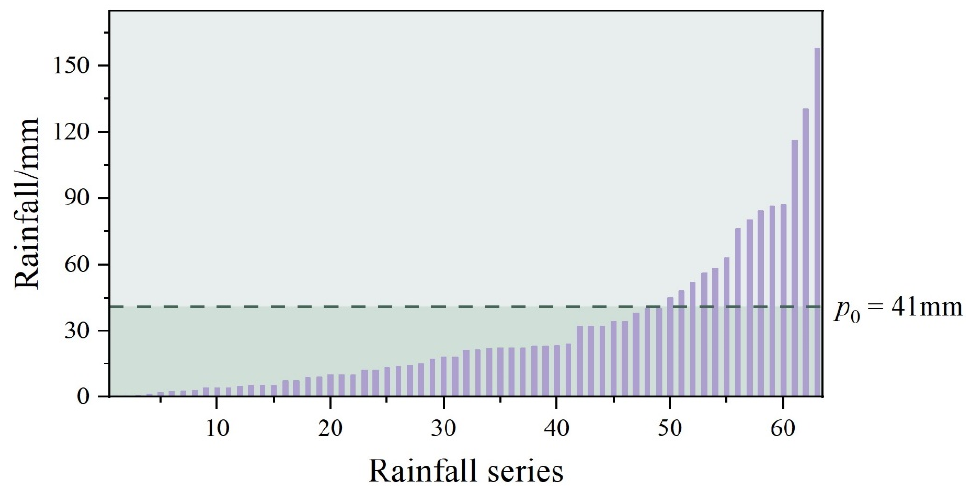
Figure 3. Rainfall series of Shenzhen.